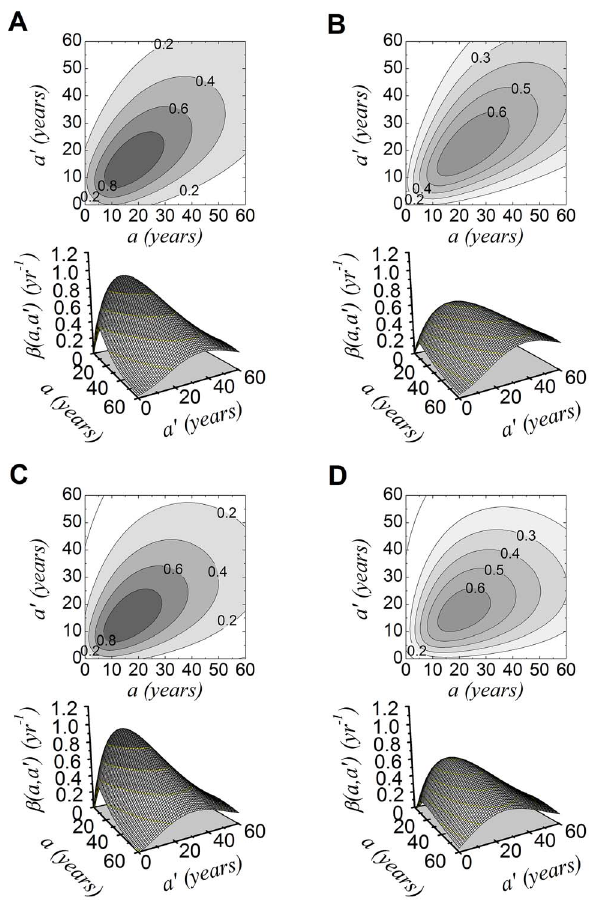
Figure 4. The contact function b ( a , a ’ ) and the respective contour plot for the intermediate (A, assortative; C, assortative with food and water transmission) and low (B, assortative; D, assortative with food and water transmission) endemicity areas. The fitted parameters were: (A) b 1 ~ 0 : 0860 year 2 2 , b 2 ~ 0 : 0397 year 2 1 , b 3 ~ 10 : 6 year and b 4 ~ 0 : 34 ; (B) b 1 ~ 0 : 0442 year 2 2 , b 2 ~ 0 : 0304 year 2 1 , b 3 ~ 8 : 1 year and b 4 ~ 0 : 42 ; (C) b 1 ~ 0 : 097 year 2 2 , b 2 ~ 0 : 0412 year 2 1 , b 3 ~ 8 : 0 year, b 4 ~ 0 : 45 and b 5 ~{ 0 : 07 year 2 1 ; (D) b 1 ~ 0 : 061 year 2 2 , b 2 ~ 0 : 034 year 2 1 , b 3 ~ 7 : 9 year, b 4 ~ 0 : 64 and b 5 ~{ 0 :